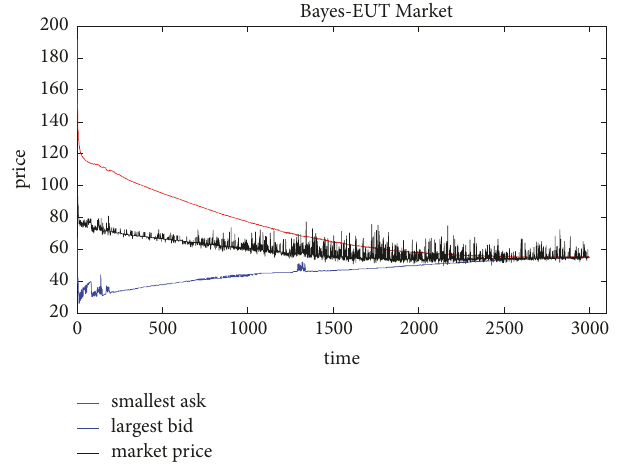
Figure 8: Smallest ask and largest bid price in the Bayes-EUT market.